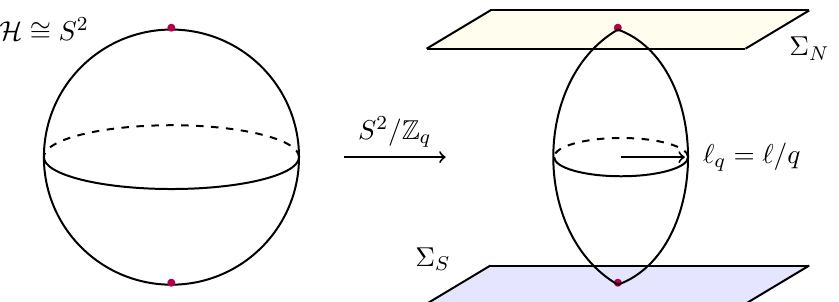
Figure 2 . The spherical geometry of the cosmological horizon H after the orbifolding deforms to that of the spindle S 2 / Z the defects located at θ = 0 , π respectively, both with induced metric